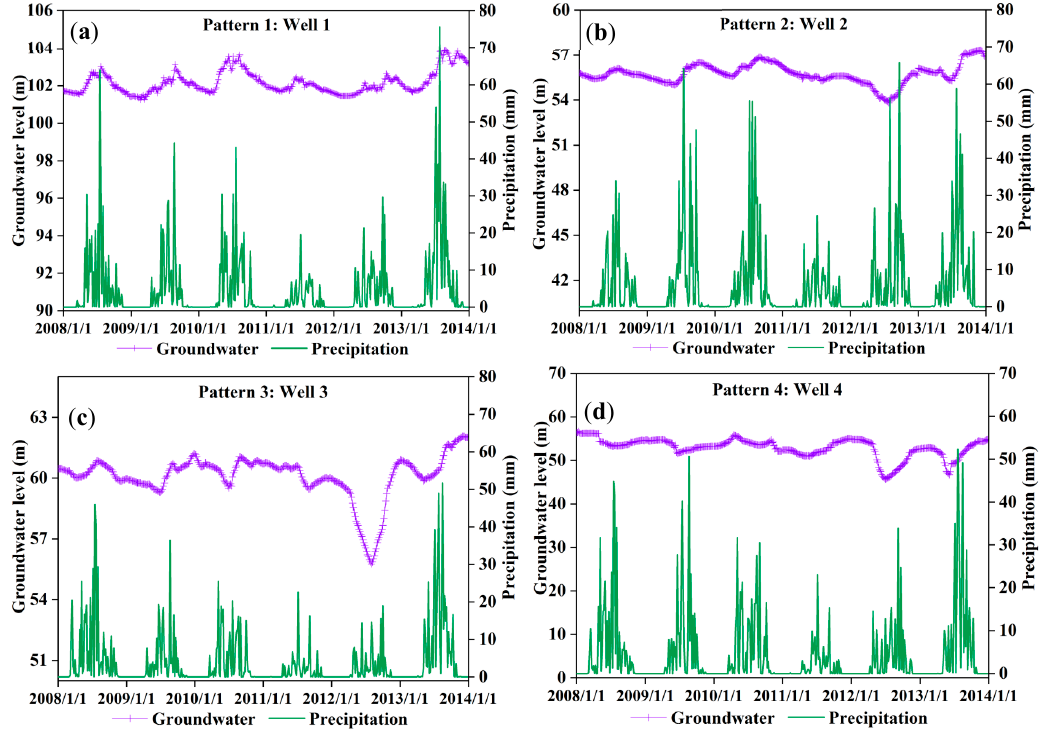
Figure 4. The time series of groundwater levels and precipitation in the Naoli River Basin, Northeast China, for pattern 1 ( a ); pattern 2 ( b ); pattern 3 ( c ) and pattern 4 ( d ) during 2008–2013.